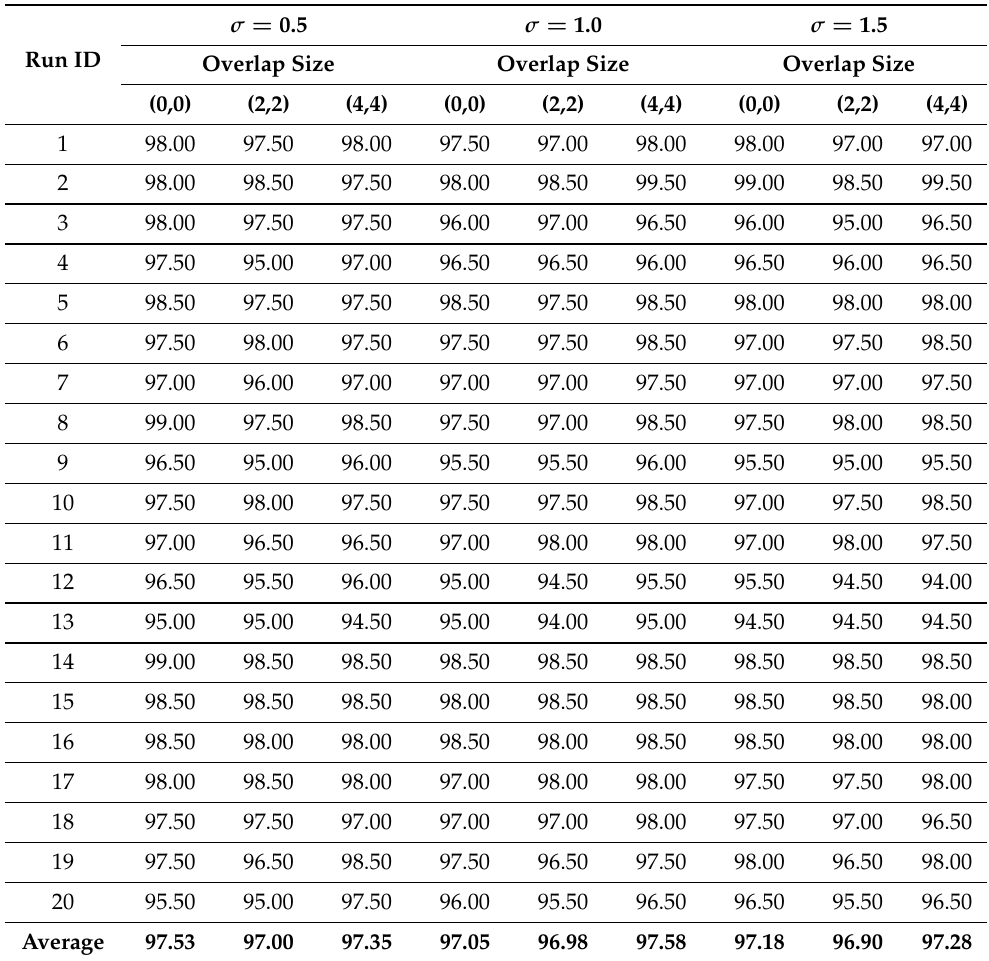
Table A5. The results of the runs for Salt and Pepper noise with density of 0.10 using different values of σ .